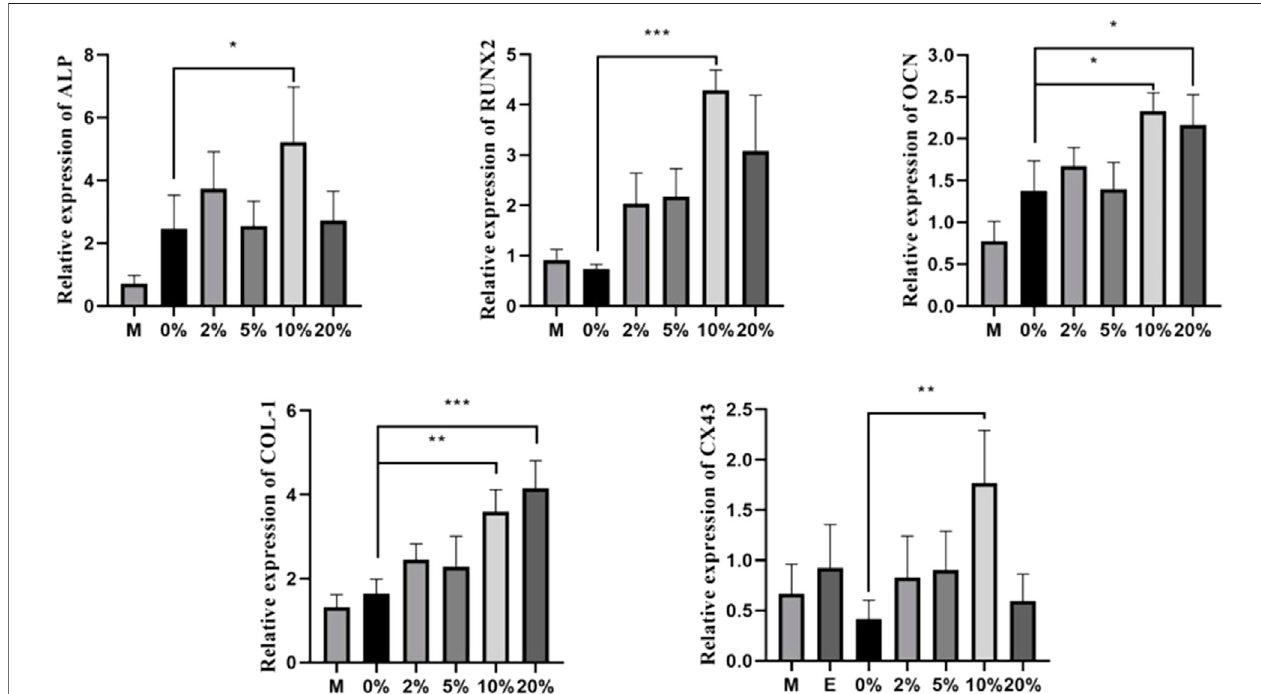
FIGURE 3 | Under different CGF concentrations, the relative expressions of osteogenic-related genes of hBMSCs in direct co-culture (* p < 0.05, ** p < 0.01, *** p < 0.001, **** p < 0.0001). (M: the group of single-cultured hBMSCs without CGF; E: the group of single-cultured HUVECs without CGF).